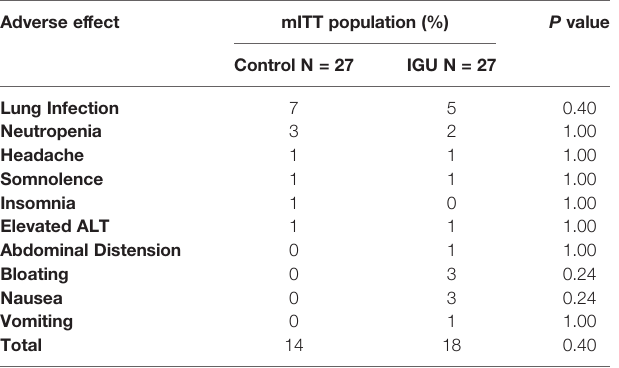
TABLE 4 | Patient reported adverse events during the trial.